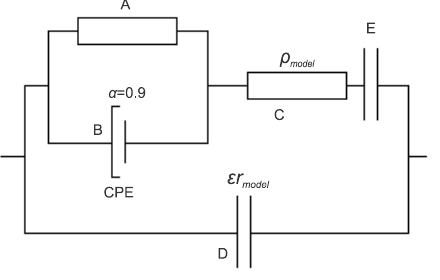
Fig. 7: The final model that modeled suspension impedance with smallest fitting error.